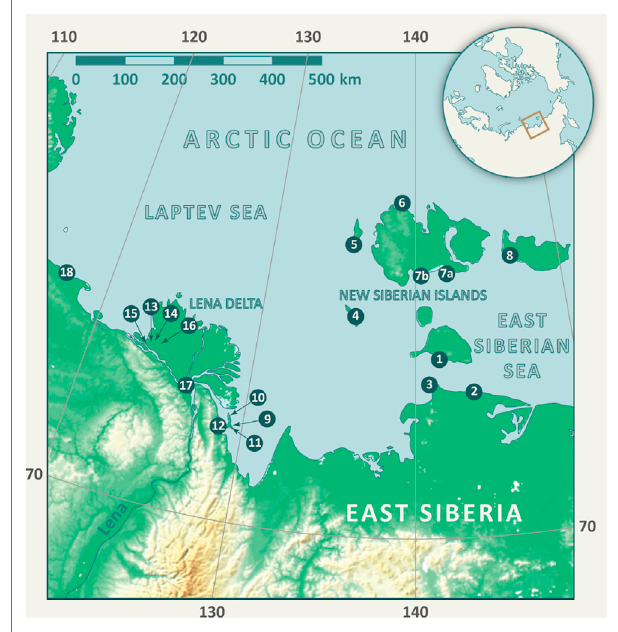
FIGURE 1 | Position of the study region in the Laptev Sea area and the positions of the study sites. 1 — Bol ’ shoy Lyakhovsky Island; 2 — Oyogos